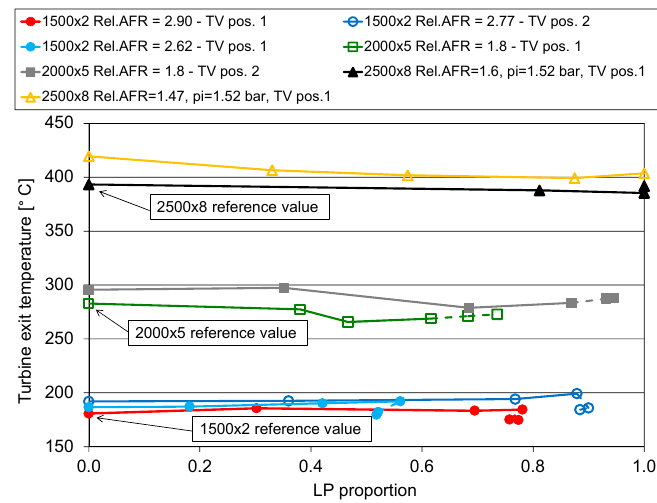
Figure 13. Turbine exit temperature as a function of LP proportion in different operating modes.